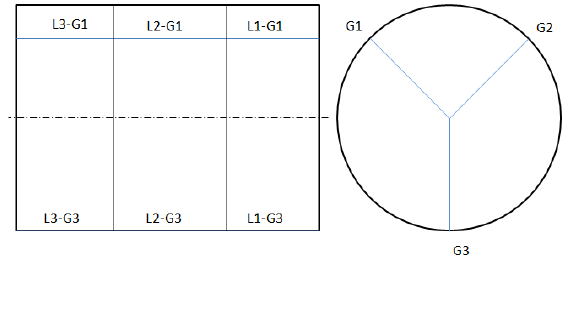
Figure 1. Side and from view of the